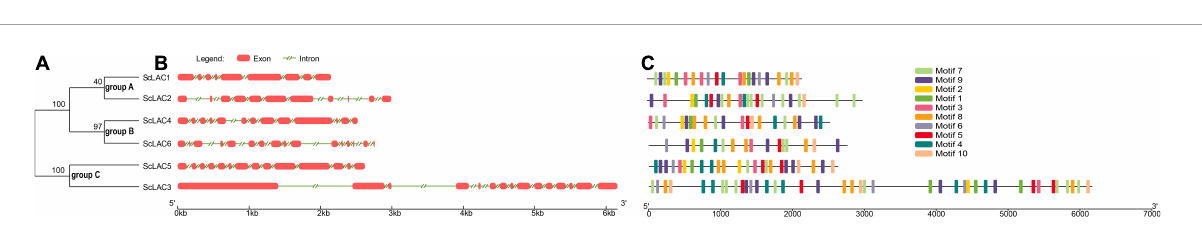
FIGURE2 Phylogenetic relationships, gene structure, and motif compositions of the Schizophyllum commune 20R-7-F01 laccase gene family. (A) A neighbor-joining tree of six ScLAC protein sequences constructed using MEGA v7.0. (B) The structure of the six ScLAC genes. Red squares correspond to exons and shrinked green lines indicate introns. (C) Schematic motif composition of six ScLAC genes. The colored boxes represent the different motifs, indicated in the top right-hand corner. The scales at the bottom of the image indicate the estimated exon/intron and motif length in